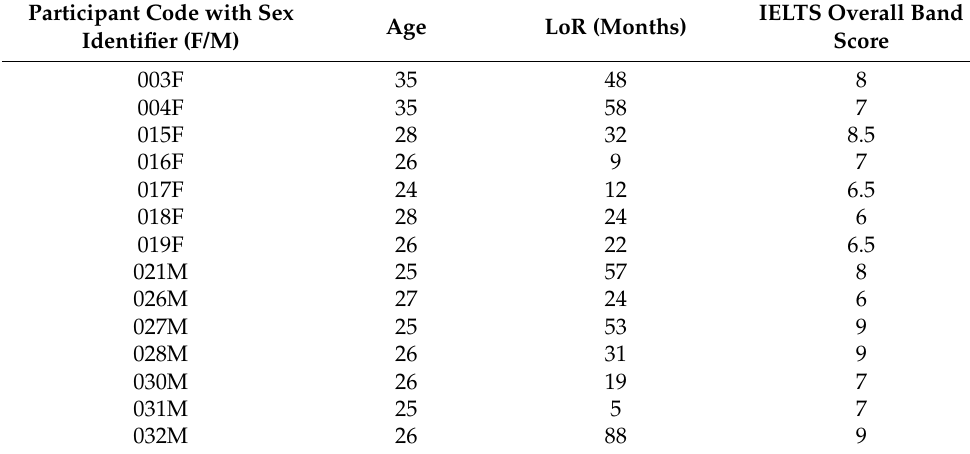
Table 3. Participant